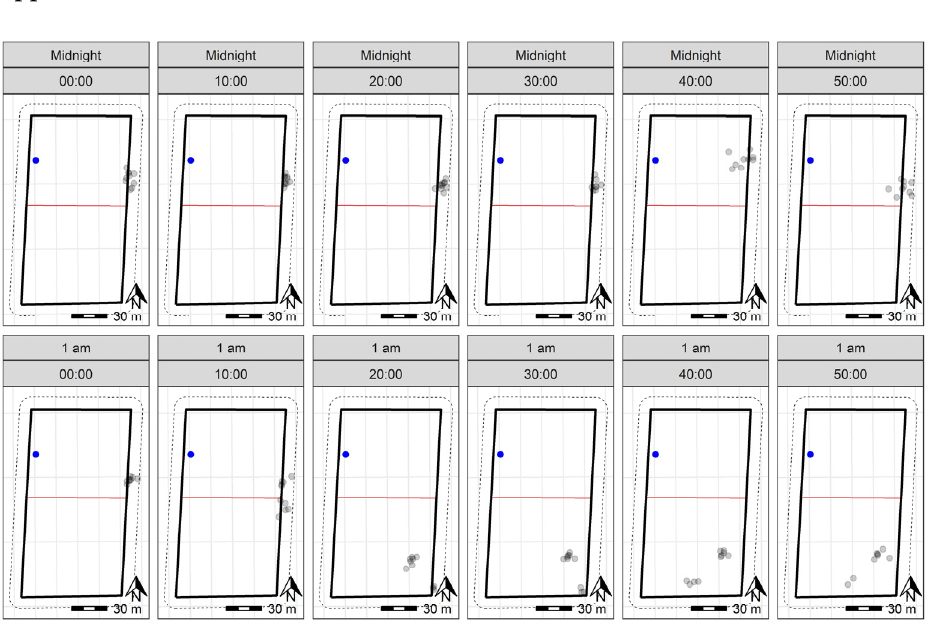
Figure A1. GPS plots across 10 min periods from midnight until 02:00 on day four of the trial for 10 sheep at Lameroo, with the water point indicated in blue. This represents the incursion period when the animals crossed through into the exclusion zone and remained there overnight. The grey points indicate the GPS positions (measured every 10 min) of individual sheep throughout the day. The solid black rectangle indicates the wire fenced paddock boundary, with the red line across the width representing the virtual fence. The dashed lines on the outside of the paddock boundary indicate the 10 m buffer zone used to clip the data to remove recording errors based on GPS drift. A scale is included to indicate paddock size.